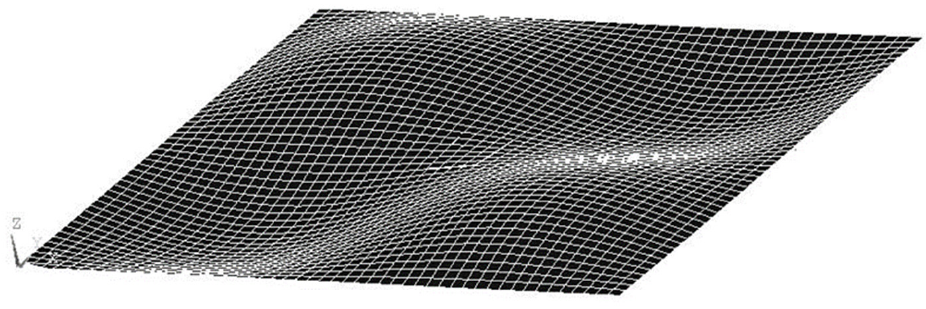
Figure 8. Mode (2,2) shape of a simply supported composite laminate plate.